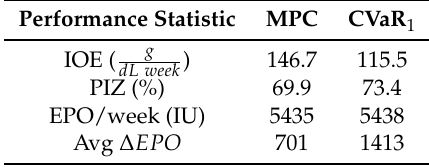
Table 3. Setpoint MPC and CVaR 1 model performance under uniform